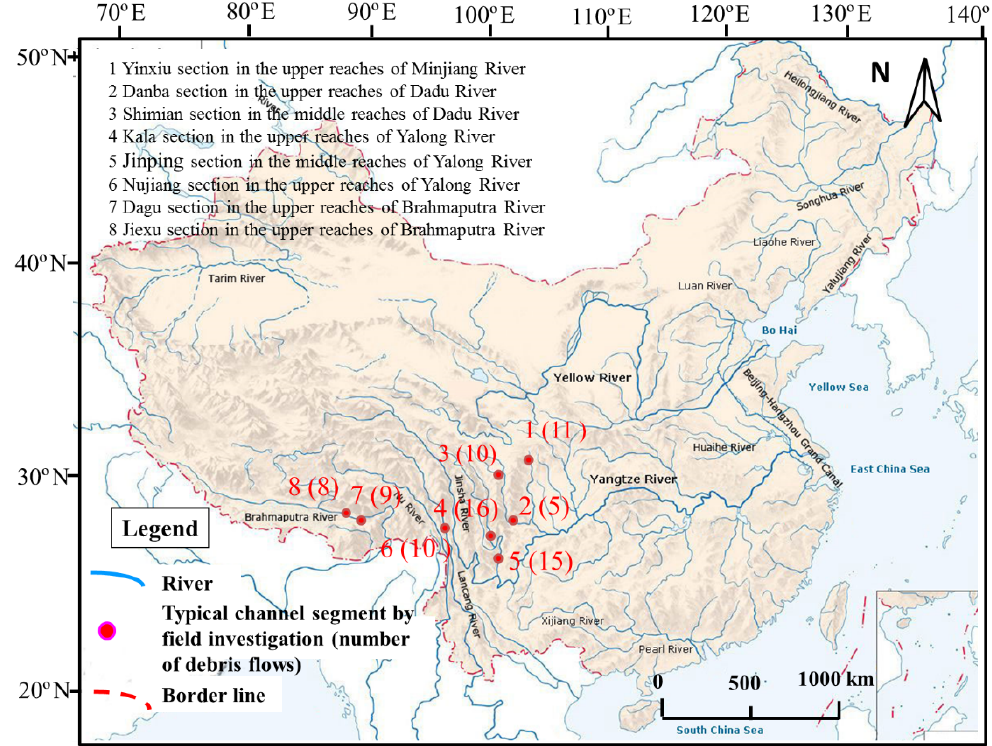
Figure 1. Distribution of the 70 debris flow gullies investigated in southwestern China (the base map is from Zhao, 2014). Publisher’s note: Please note that the above figure contains disputed